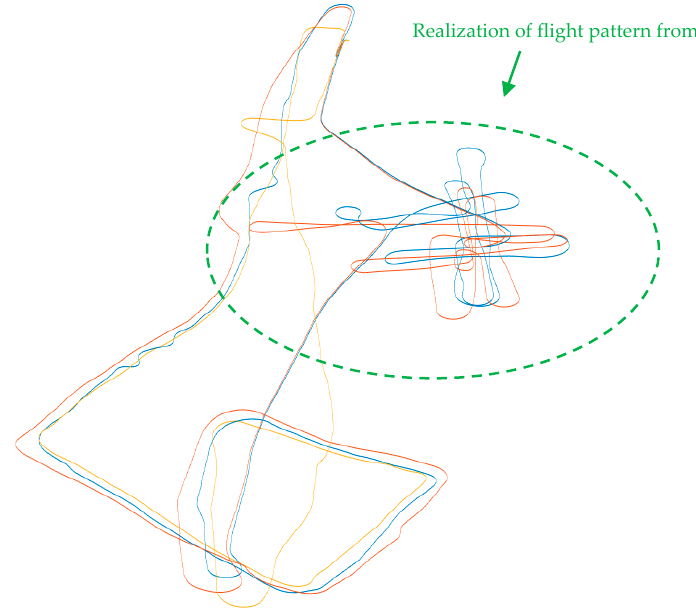
Figure 7. Flight route realized on 13 October, 2018 according to the diagram presented in Figure 6 ( SP—blue, IN1—red, IN2—yellow).